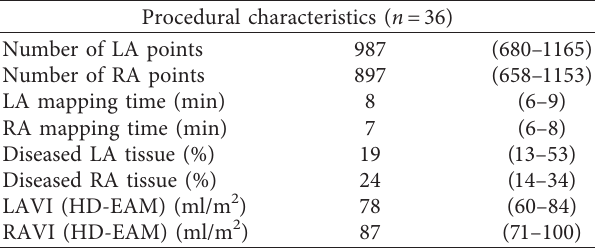
Table 2: Procedural